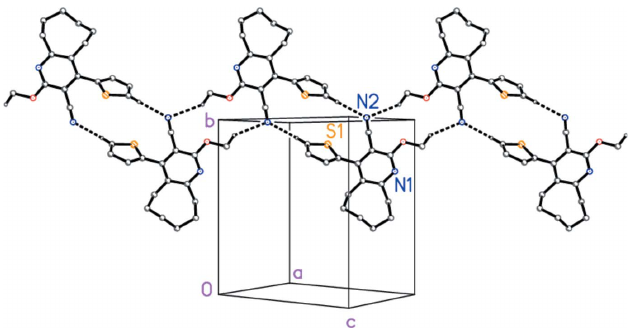
Figure 7 The molecular packing of compound 1c , viewed perpendicular to (101), showing the ‘weak’ hydrogen bonds (drawn as dashed bonds). Atom labels indicate the asymmetric